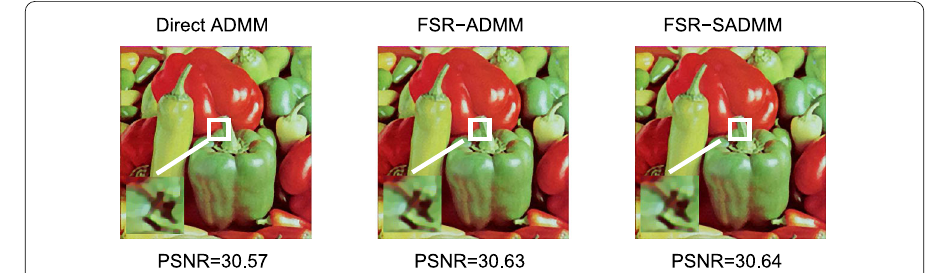
Figure 1 From left to right: super-resolution Peppers by direct ADMM, FSR-ADMM, and FSR-SADMM.